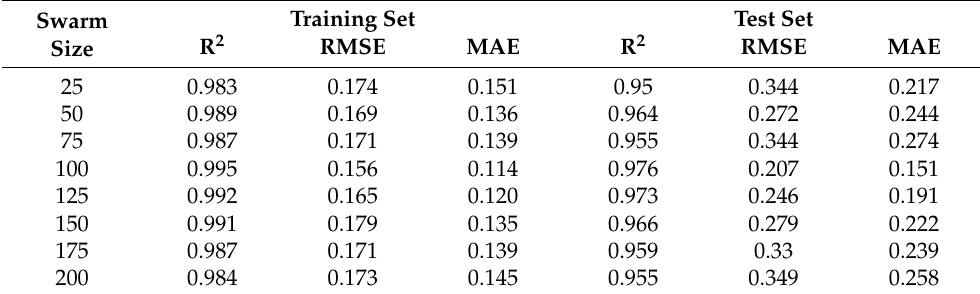
Figure 5. Variation of fitness value and the number of iterations of the WOA-XGBoost model with different population sizes. Table 3. The performance indexes of the WOA-XGBoost model with different population